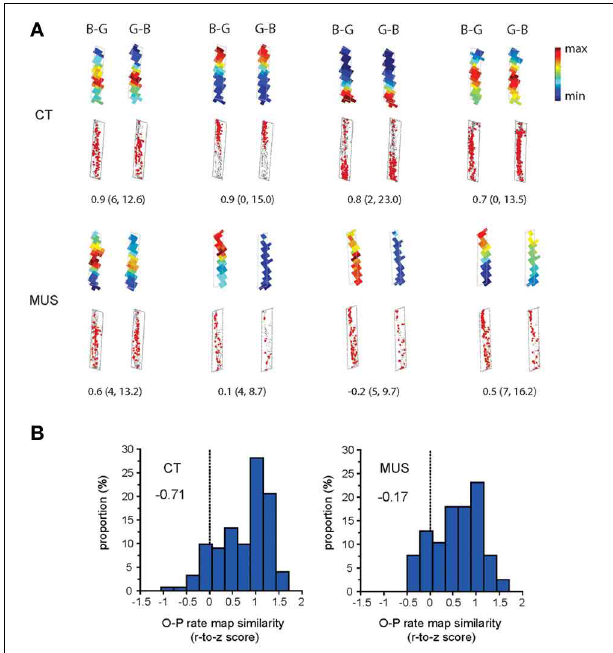
FIGURE 5 | O-P firing pattern under MUS in PER. (A) Representative examples of the within-arm firing rate maps associated with O-P trial type. B-G and G-B indicate the configural arrangement of objects (B: obj-B, G: obj-G) in the choice platform at the end of the arm. Raw spiking maps using the same illustration scheme as Figure 4A are shown under the rate maps. Only the firing patterns for the areas included in analyses (i.e., arm regions) are shown (choice platform thus excluded). The number underneath each pair of rate maps indicates the Pearson correlation coefficient. The minimum and maximum firing rates (Hz) used for color-scaling the rate maps are parenthesized. (B) The neuronal distribution of the Pearson correlation coefficients (Fisher r-to-z transformed scores) calculated between the firing rate maps associated with O-P trial type in each drug condition. A more negatively skewed distribution means higher similarity in firing patterns between different trial conditions belonging to the same strategy-dependent trial type. Note the highly negatively skewed distribution in CT compared to MUS (skewness measures provided inside the graphs) for rule-compatible (O-P) trial